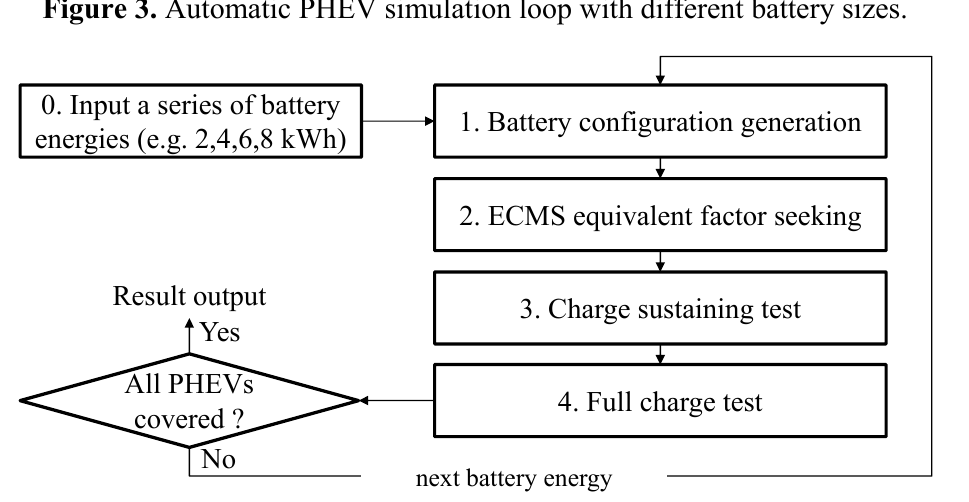
Figure 3. Automatic PHEV simulation loop with different battery